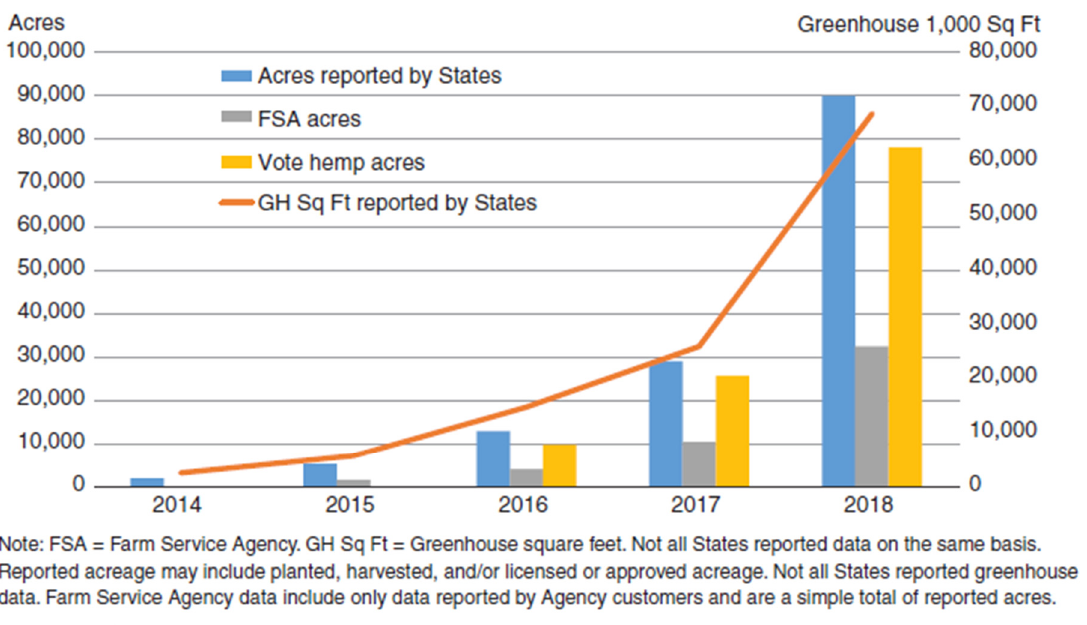
Figure 2. United States hemp acreage and greenhouse area, reported 2014–2018. Graphic is from Tyler et al. [7].